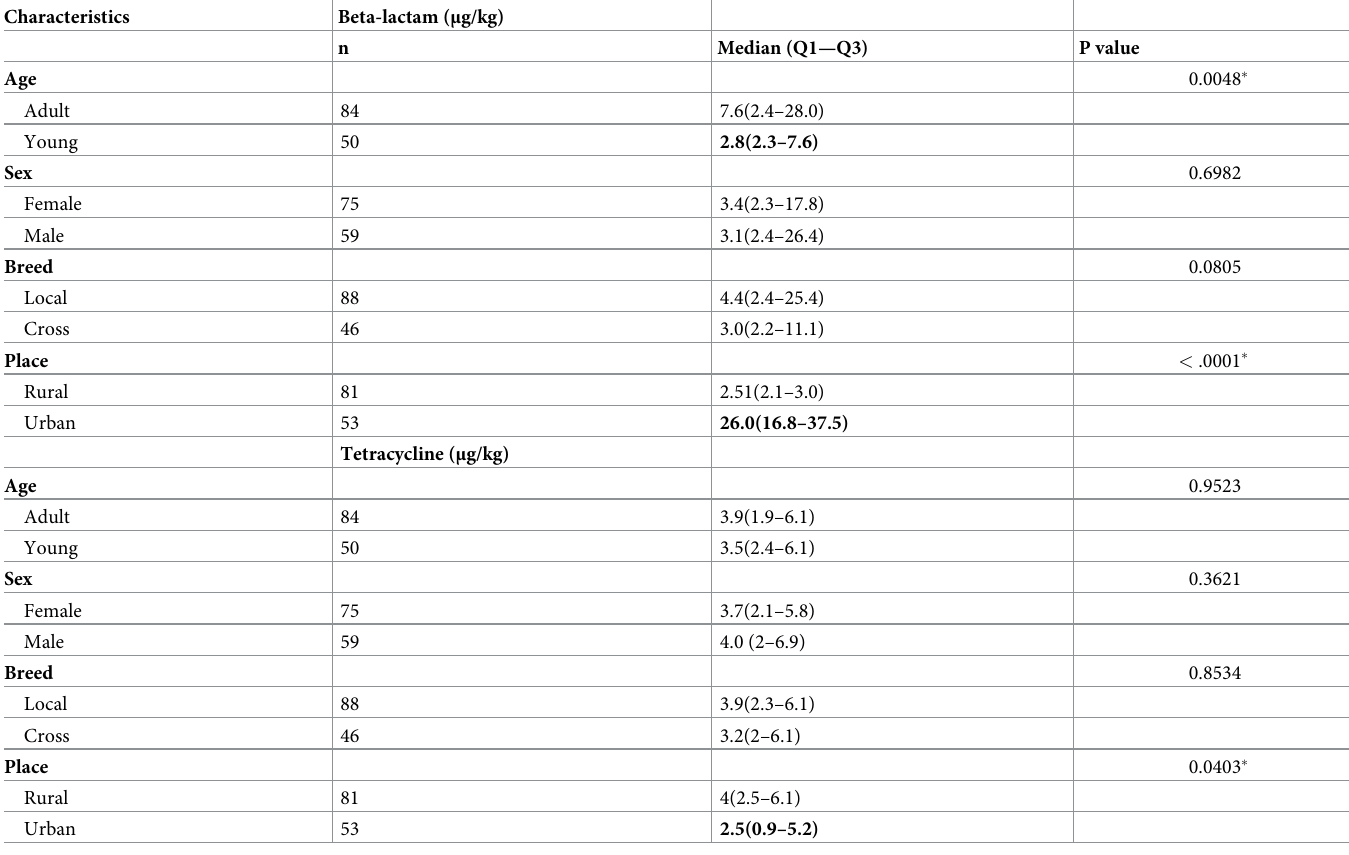
Table 2. Antimicrobial concentration levels in cattle carcass